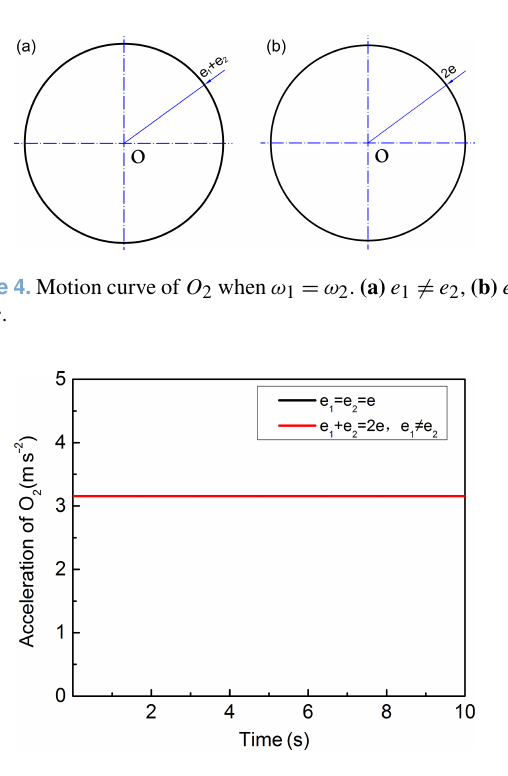
Figure 5. Effects of e 1 and e 2 on the acceleration when ω 1 = ω 2 ( e 1 + e 2 = 2 e ).